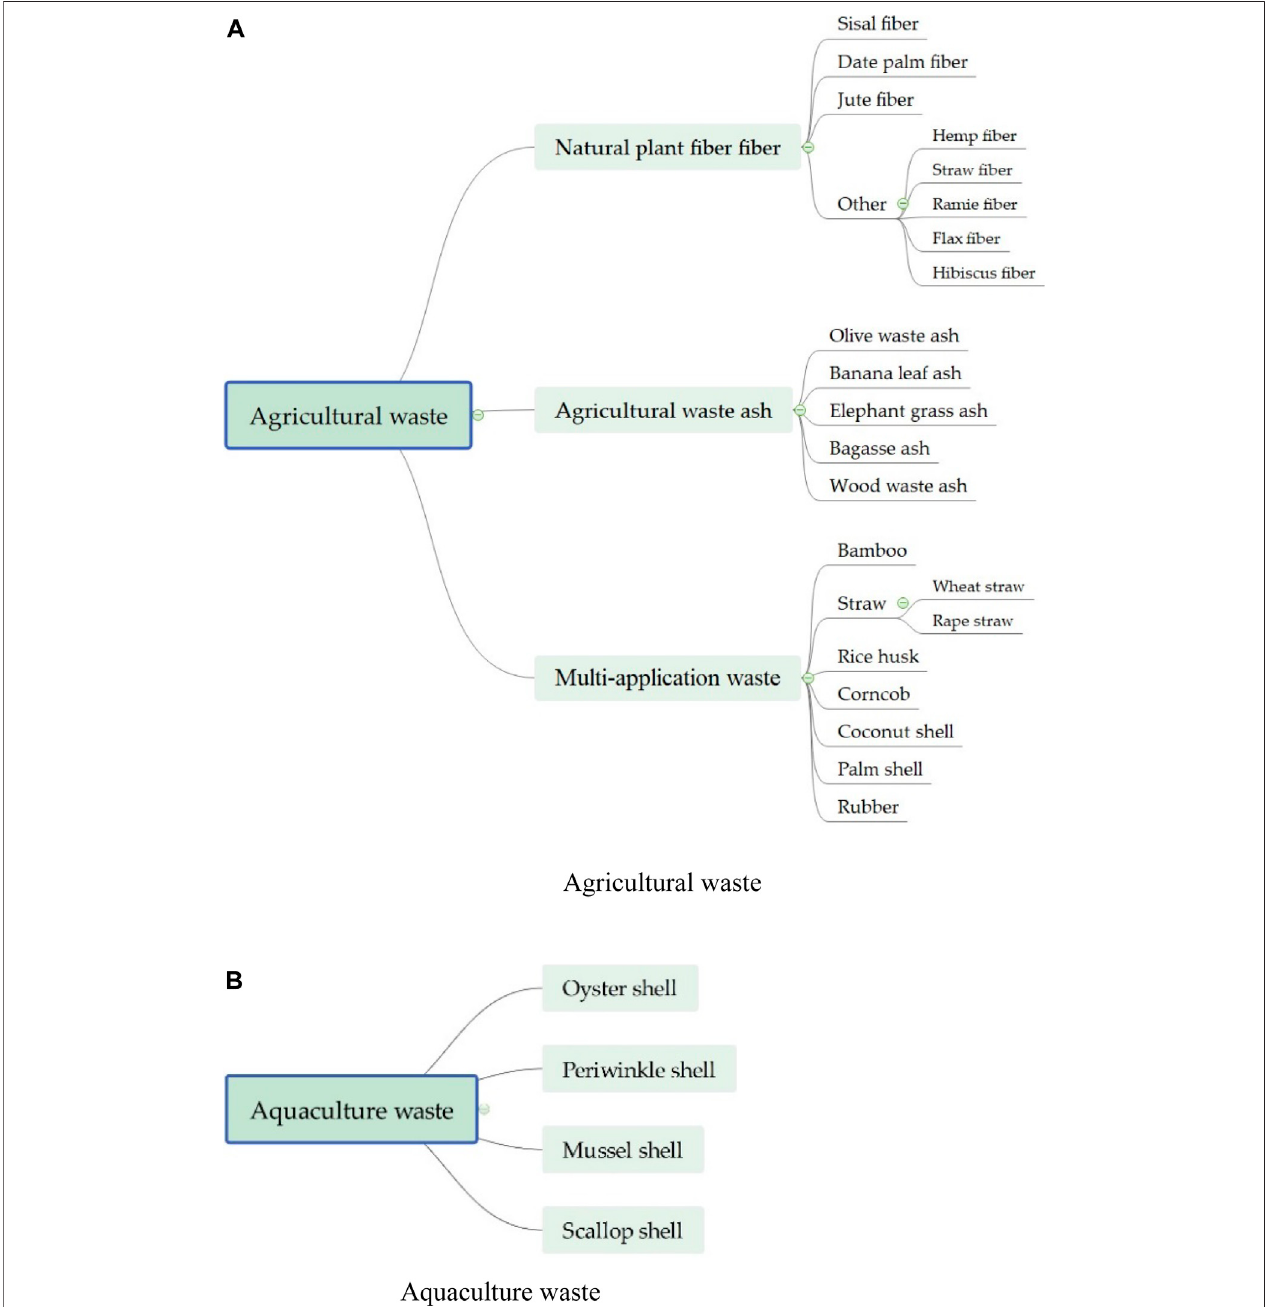
FIGURE 1 | Classi fi cation of agricultural and aquaculture waste in the